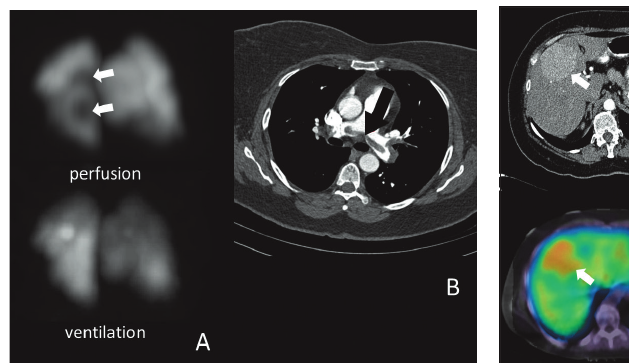
Fig. 7. Different cases showing liver lesions on CT with characterisation being confirmed as (A) focal nodular hyperplasia with increased [Tc-99m] colloid uptake, (B) and as haemangioma with intense [Tc-99m]-labelled red blood cell uptake.